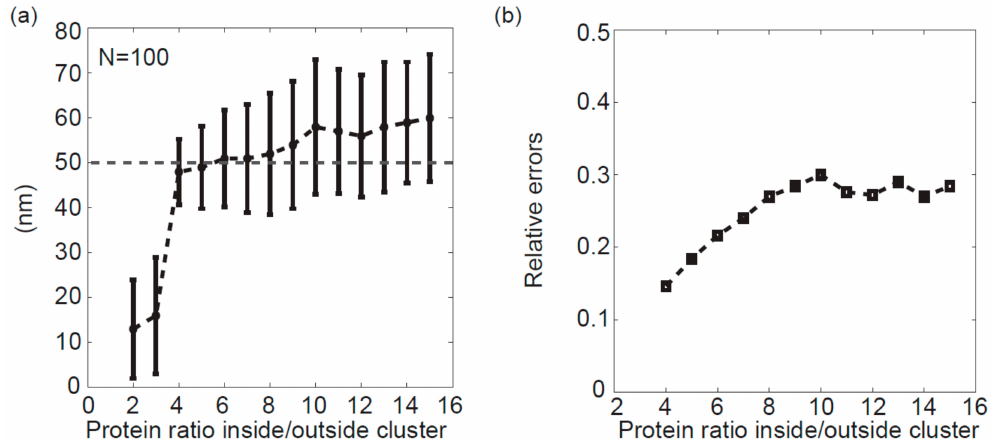
Figure 4. ( a ) Peak analysis results for 14 types of modeled SMLM images containing 10 randomly distributed clusters with di ff erent protein ratios inside / outside clusters (2 to 15). ( b ) The relative errors of cluster radius predicted by peak analysis versus the protein